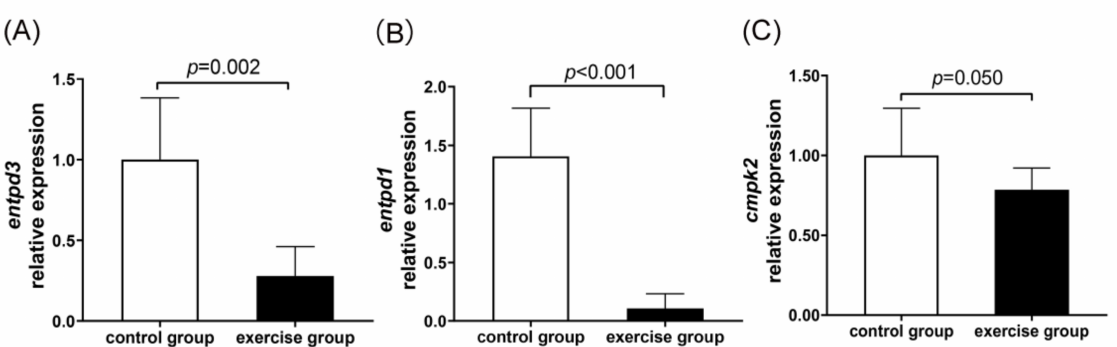
Figure 9. The results of mRNA expression by qRT-PCR for entpd3 ( A ), entpd1 ( B ), and cmpk2 ( C , the core genes) in the control and exercise groups. All values are presented as mean and standard deviation. Student’s t test was used to compare the differences between the two groups.